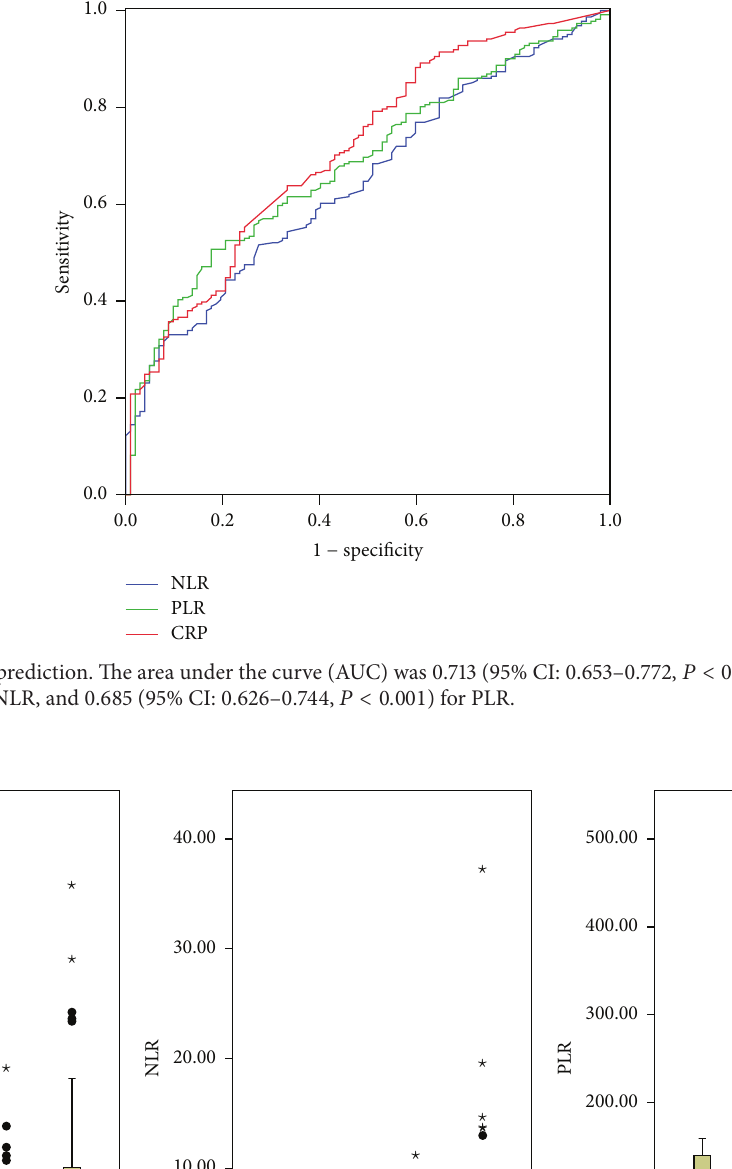
Figure 5) (I0 versus I1, 𝑃 = 0.002 ; I1 versus I2, 𝑃 = 0.012